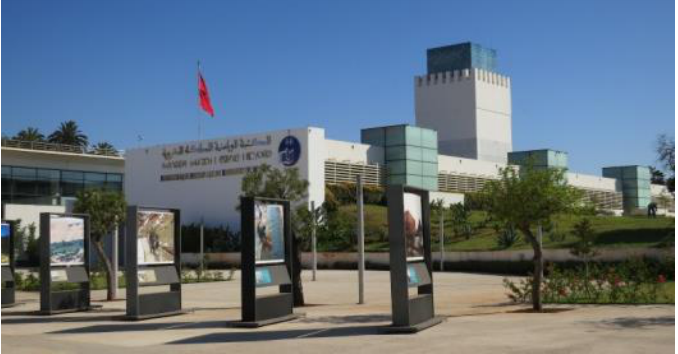
Figure 3: The national